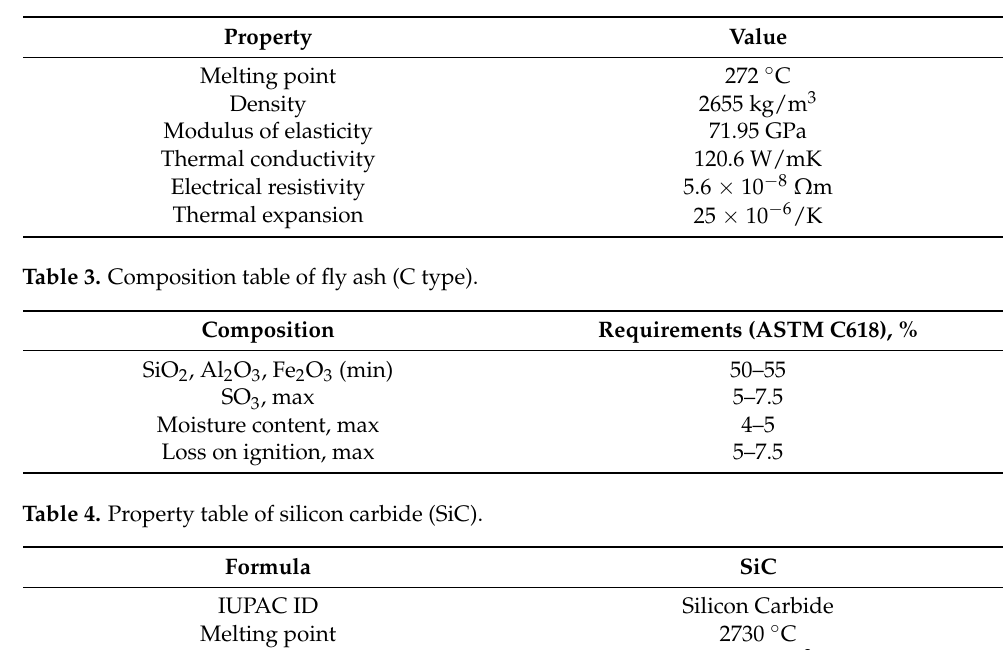
Table 2. Properties of the matrix material (AA 5083).